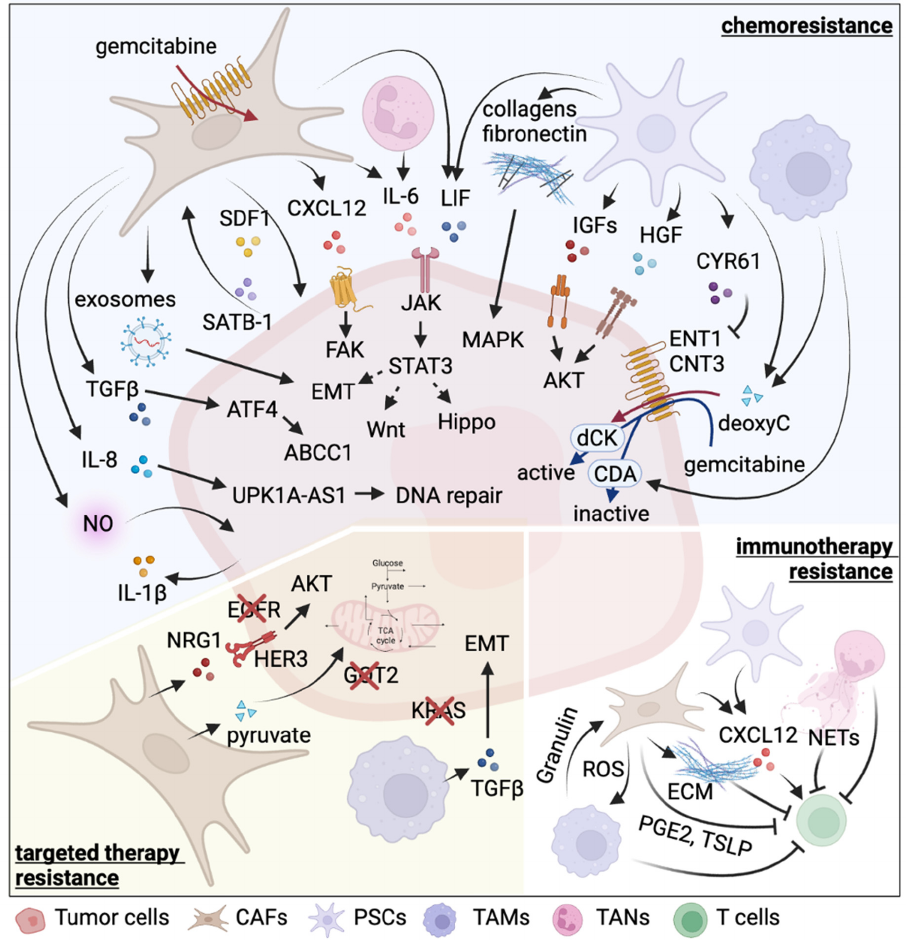
Figure 2. Therapy resistance mechanisms driven by the tumor microenvironment in pancreatic cancer. Role of the TME in chemoresistance are extensively studied, while its function in regulating tumor response to novel therapeutics needs further investigation. For chemoresistance mechanisms, the TME mainly provides growth factors to promote tumor cell survival and decreases the uptake or inactivate chemo drugs. For targeted therapy resistance, the TME usually nourishes tumor cells by activating parallel or alternative pathways. For immunotherapy resistance, the TME not only forms physical barriers to prevent the cytotoxic immune cell infiltration, but also produces immune suppressive factors to inactivate them. CDA, cytidine deaminase; dCK, deoxycytidine kinase; deoxyC,